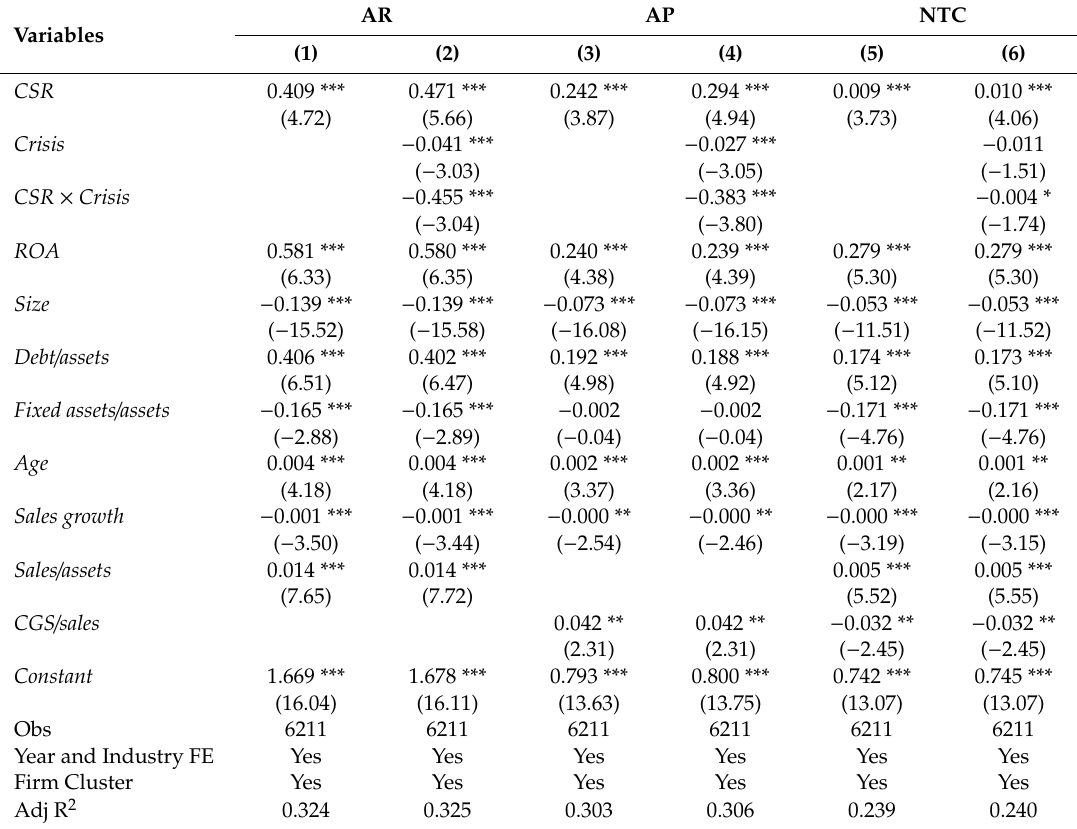
Table 5. Alternate proxies for corporate social responsibility (CSR) and trade